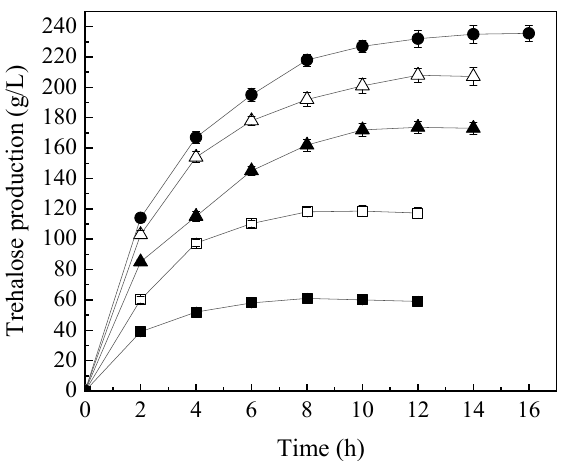
Figure 5. The production of trehalose by whole-cell biocatalysis with different initial maltose concentrations. The initial maltose concentrations are represented by different signals: filled square, 100 g/L; empty square, 200 g/L; filled triangle, 300 g/L; empty triangle, 400 g/L; filled circle, 500 g/L. The error bars represent the standard deviation of three independent replicates.